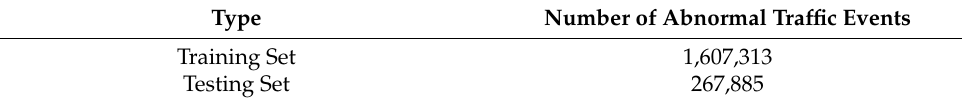
Table 5. Abnormal